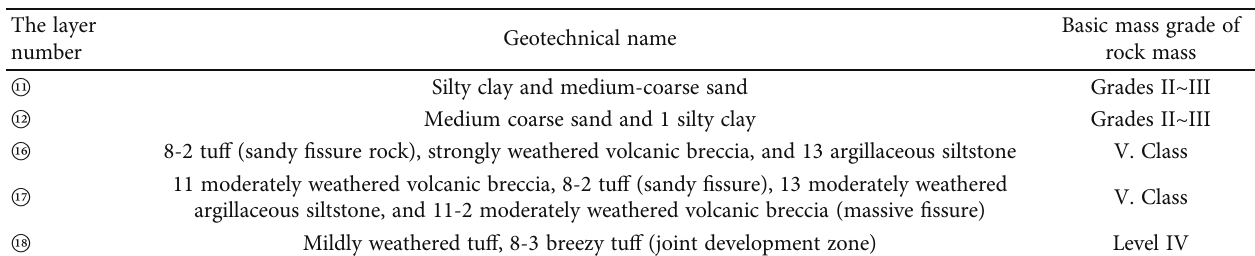
Table 2: Interval main